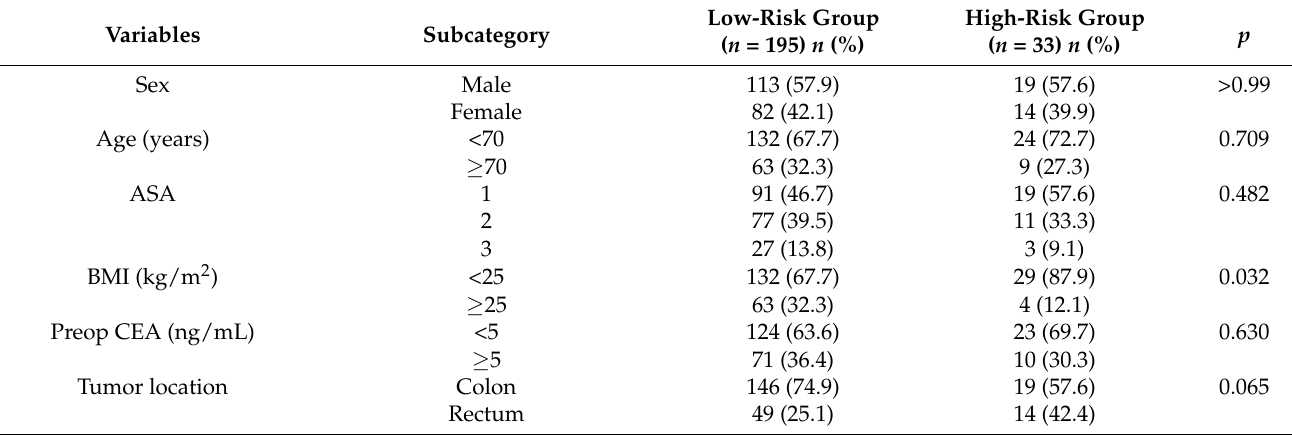
Table 2. Comparison of patients’ demographics between the high-risk group and the low-risk group in the training set.